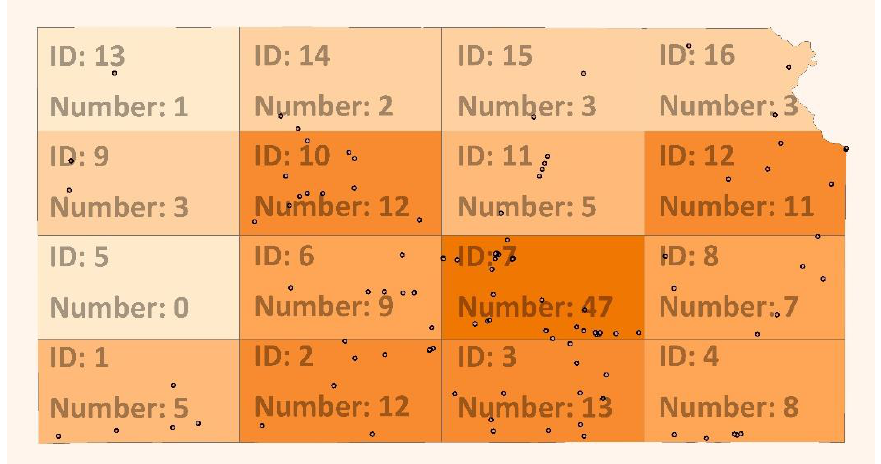
Figure 5. The identification number and number of failure events that occurred in each sensor field.